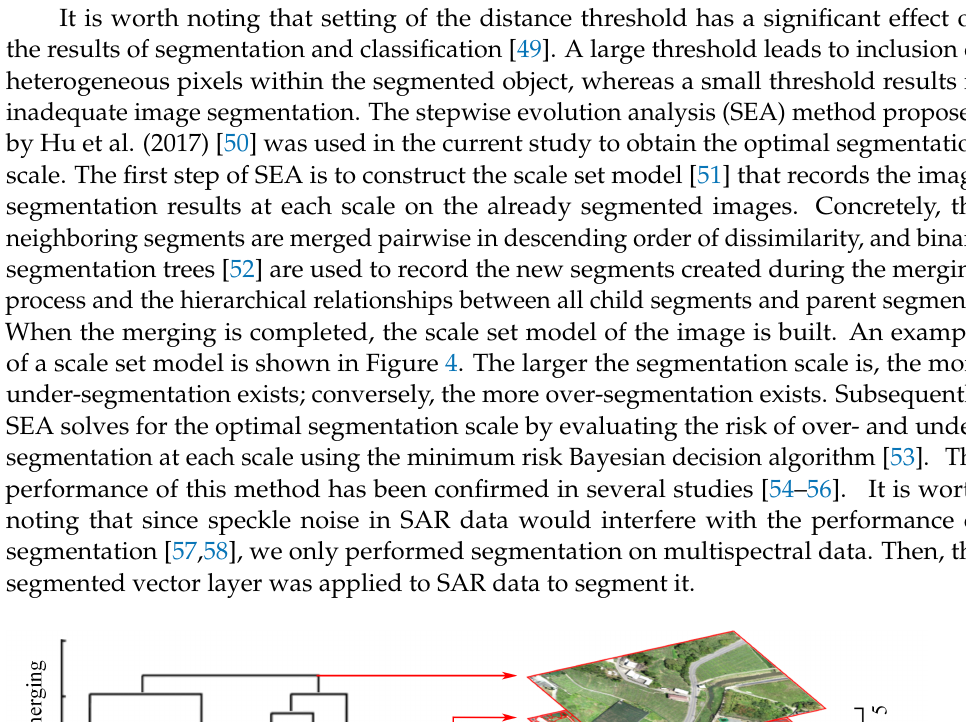
Figure 3. Schematic diagram showing watershed segmentation.